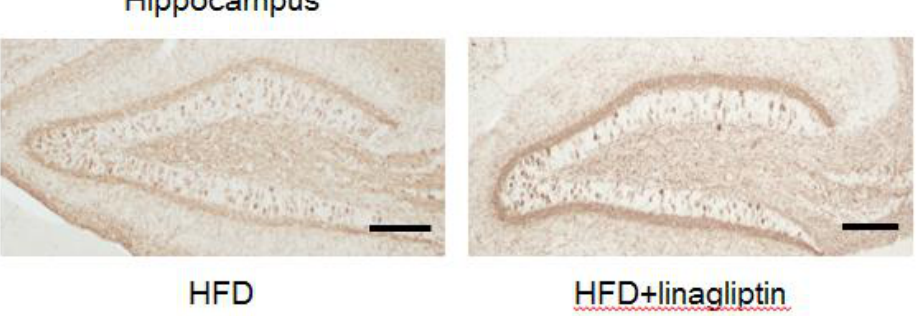
Figure 4. Immunohistochemical assessment of phosphorylated tau pathology in the hippocampus after the administration of linagliptin. Representative images of phosphorylated tau staining in vehicle-treated (left) and linagliptin-treated mice (right) at 8 months of age. Bar = 100 µ m